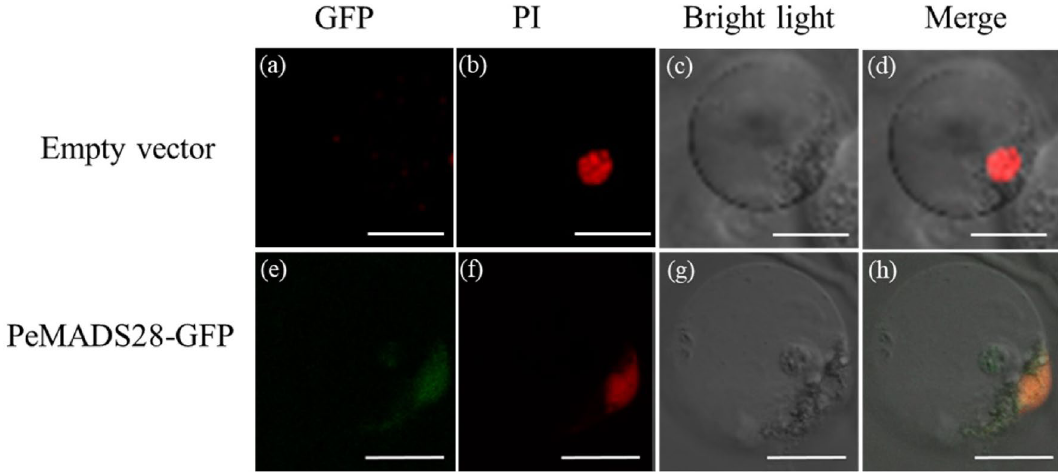
Figure 4. Localization patterns of PeMADS28-GFP fusions in Phalaenopsis protoplasts. Images show fluorescence and bright-field confocal microscopy images and merged images of flower protoplast. ( a ) Empty vector was no green fluorescence in the cytoplasm and nucleus. ( b ) Cell in ( a ) stained with propidium iodide (PI) represented in red to confirm the nucleus. ( c ) Cell in ( a ) and ( b ) by bright-field confocal microscopy. ( d ) Merged image of ( a ), ( b ) and ( c ) to confirm green fluorescence in the cytoplasm of a flower cell. ( e ) PeMADS28- GFP green fluorescence in nucleus and cytoplasm. ( f ) Cell in ( e ) stained with PI represented in red to confirm the nucleus. ( g ) Cell in ( e ) and ( f ) by bright-field confocal microscopy. ( h ) Merged image of ( e ), ( f ) and ( g ) to confirm green fluorescence in cytoplasm. Bars: 20